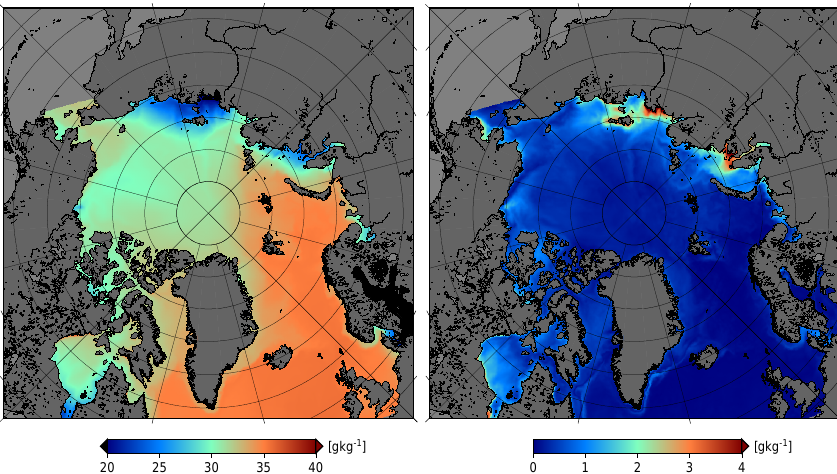
Figure 4. Mean (left map) and standard deviation (right map) of weekly sea surface salinity for the winter period from October to April, based on 8yr of daily model output.